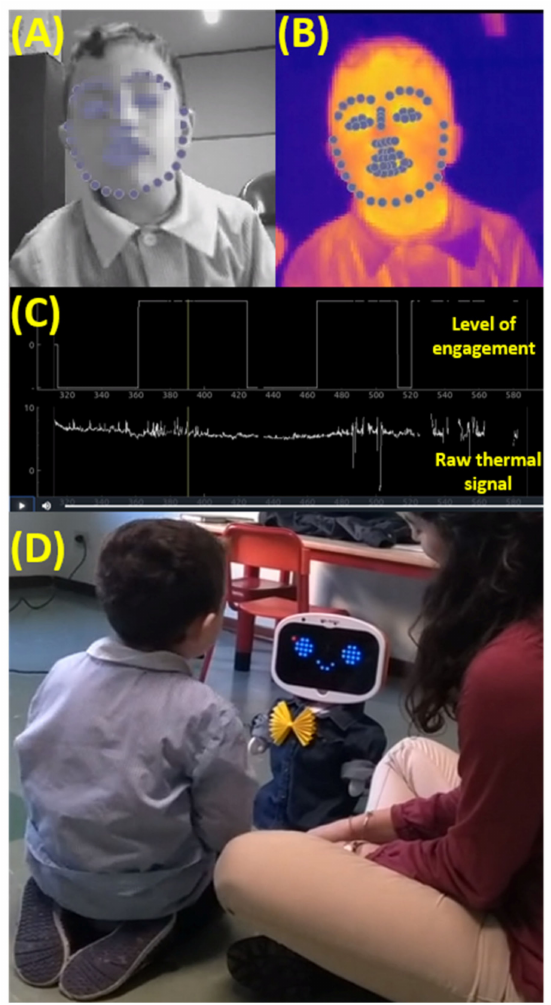
Figure 5. ( A – C ) Processing pipeline. ( A ) The first phase relied on the visible image to detect the child’s face and locate specific facial landmarks. ( B ) The corresponding landmarks on the thermal image were then obtained thanks to a previous optical calibration procedure. ( C ) The thermal signal is extracted from the nose tip region and processed in order to obtain the subject’s level of engagement. ( D ) The child–robot interactions are guided by the robot’s understanding of the child’s level of